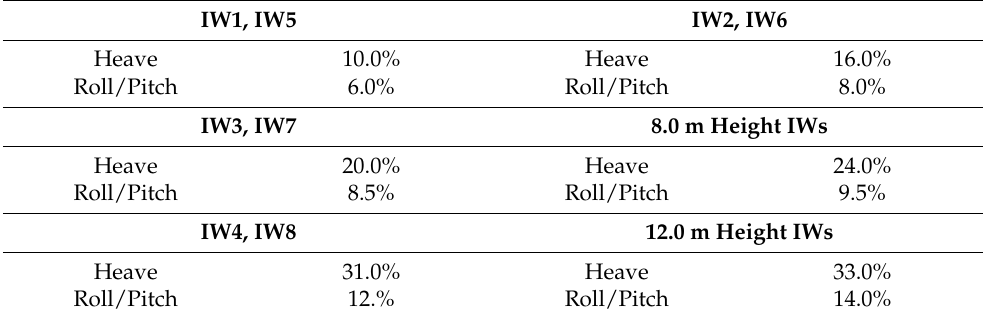
Figure 4. Free decay tests of the moored WIND-bos platform (experimental). Table 4. Damping ratios obtained from experimental free decay tests. Table 5. Damping ratios obtained iteratively for the coupled time-domain